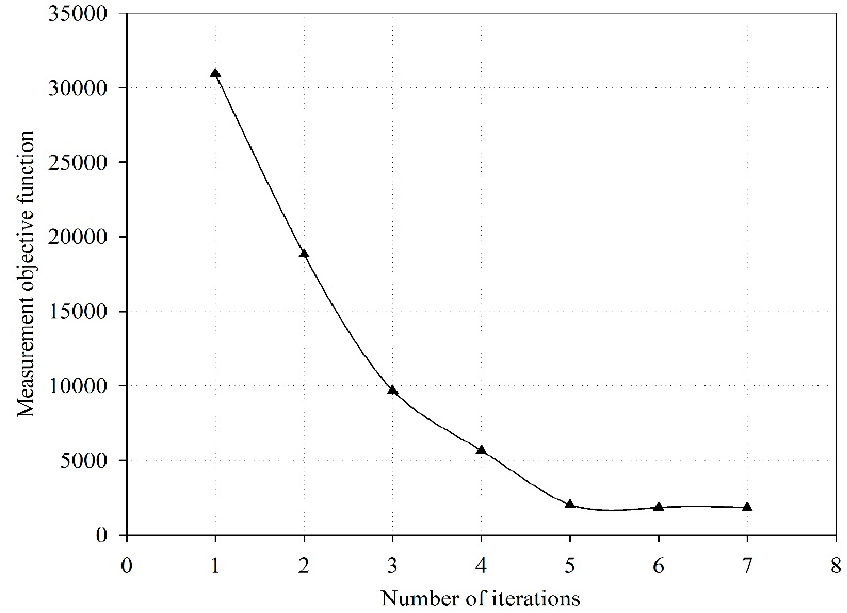
Figure 7. Development of measurement objective function (m 2 ) with each PEST iteration.